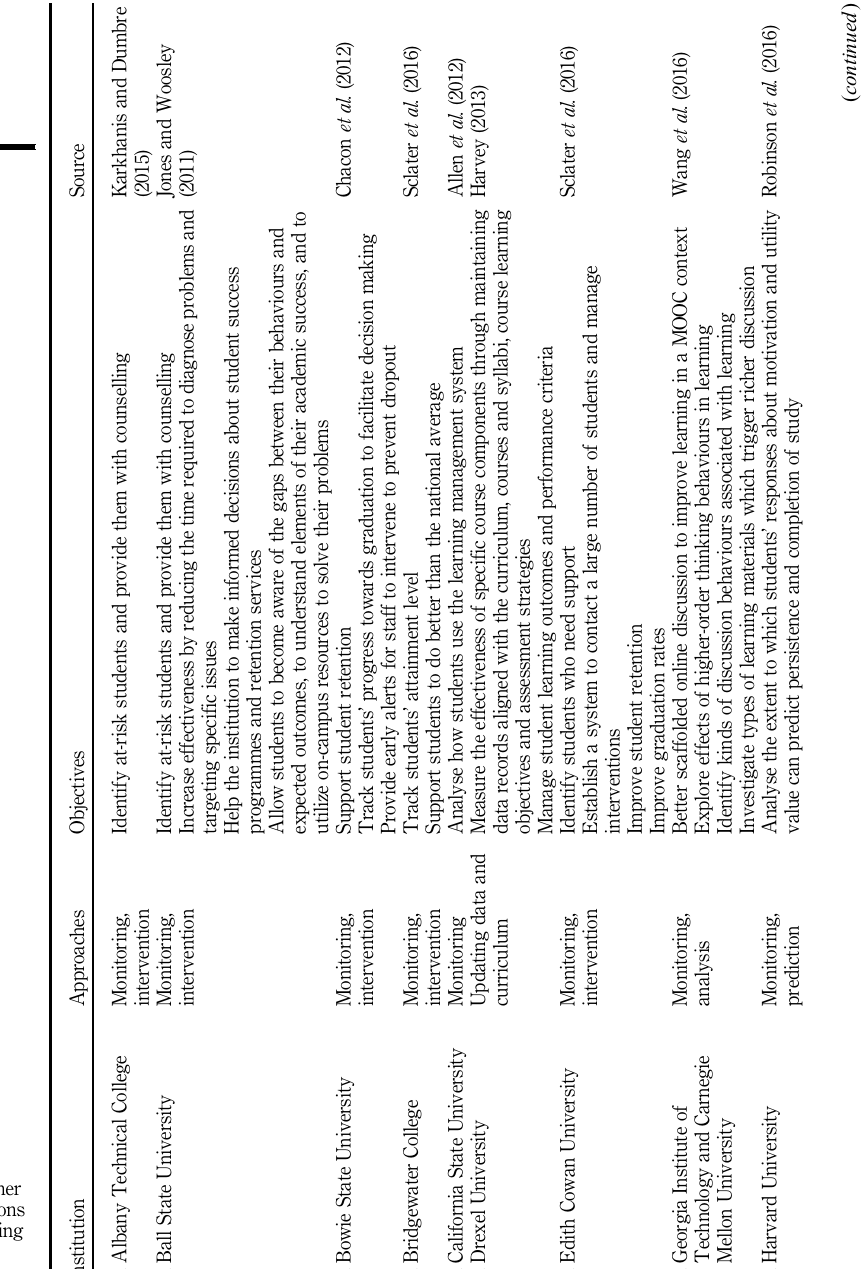
Table AI. Summary of the objectives and approaches of higher education institutions in the use of learning